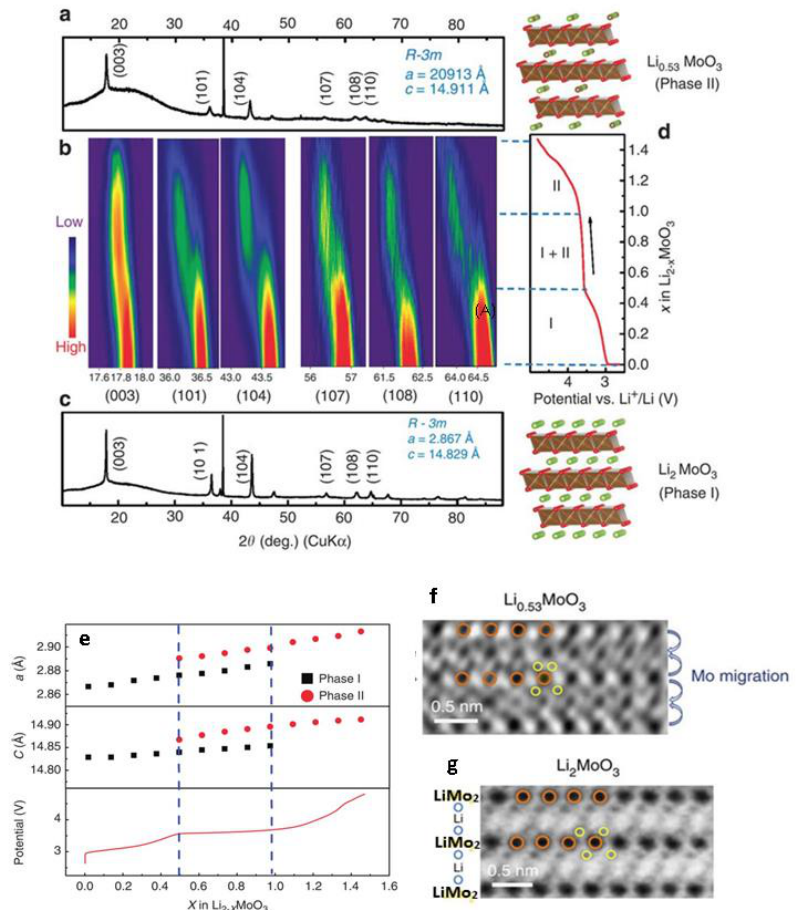
Figure 7. In-situ XRD of Li 2 MoO 3 during the first charge. ( a ) The XRD pattern of the Li 2-x MoO 3 electrode right after charging to 4.8 V; the peak at 38.5° is from Al collector. ( b ) Contour plot of the evolution of (003), (101), (104), (107), (108) and (110) peaks during charge. ( c ) The XRD pattern of the Li 2 MoO 3 electrode before charging; ( d ) Charge curve at a current density of 10 mA g −1 to 4.8 V. ( e ) Lattice parameter changes of Li 2 MoO 3 during the first charge. ( f , g ) STEM lattice images of Li 2−x MoO 3 and Li 2 MoO 3, respectively; where black: Mo, white: Li and yellow: O [162]; with permission from Springer Nature.